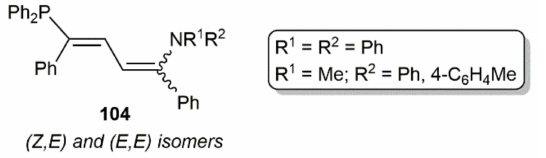
Figure 14. Structure of the 1,3-butadiene derivatives 104